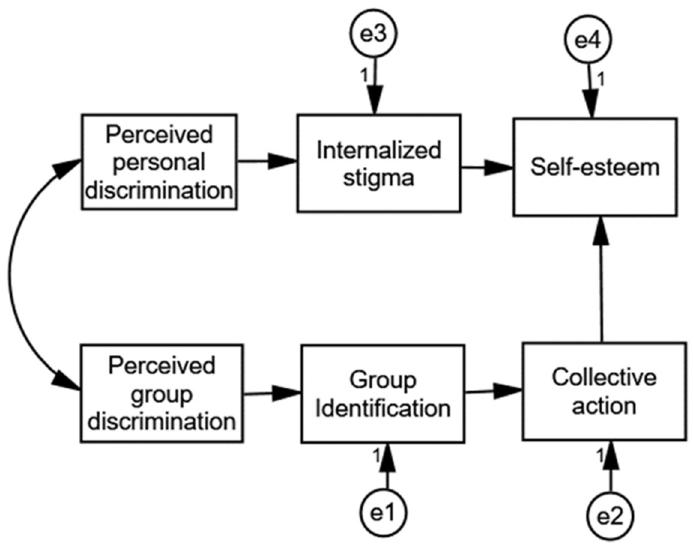
Figure 1. Mediating model proposed for people with hearing and visual impairments.